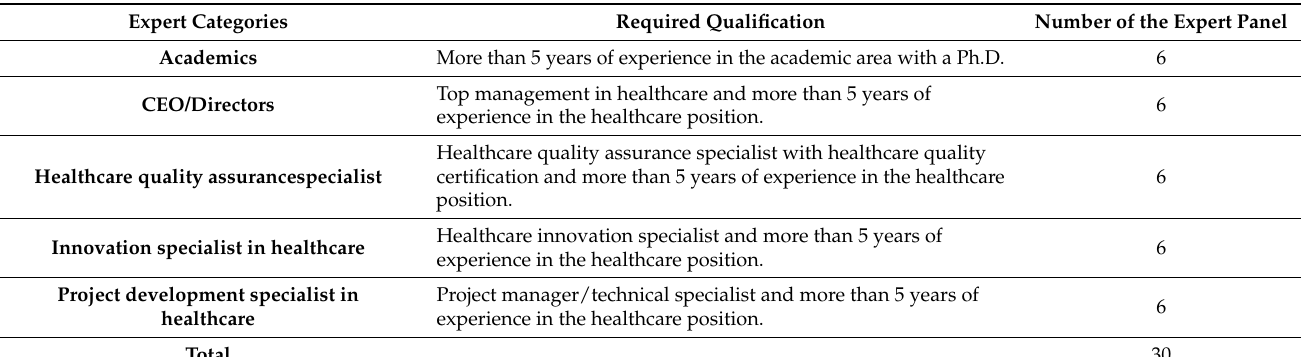
Table 1. Healthcare expert panel